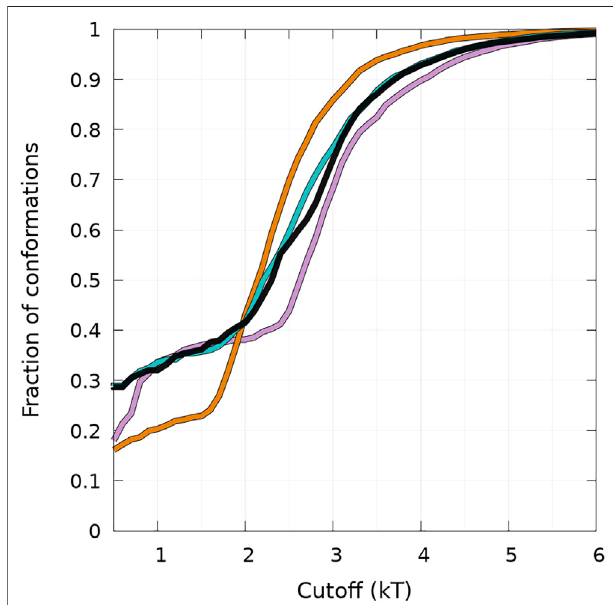
FIGURE 5 | Cumulative fraction of the total number of conformations simulated as a function of a free-energy cutoff (in kT units) from the global minimum of the B state (see text) represented in Figure 4 . Curves are for WT (black), A30P (purple), E46K (turquoise), and A53T